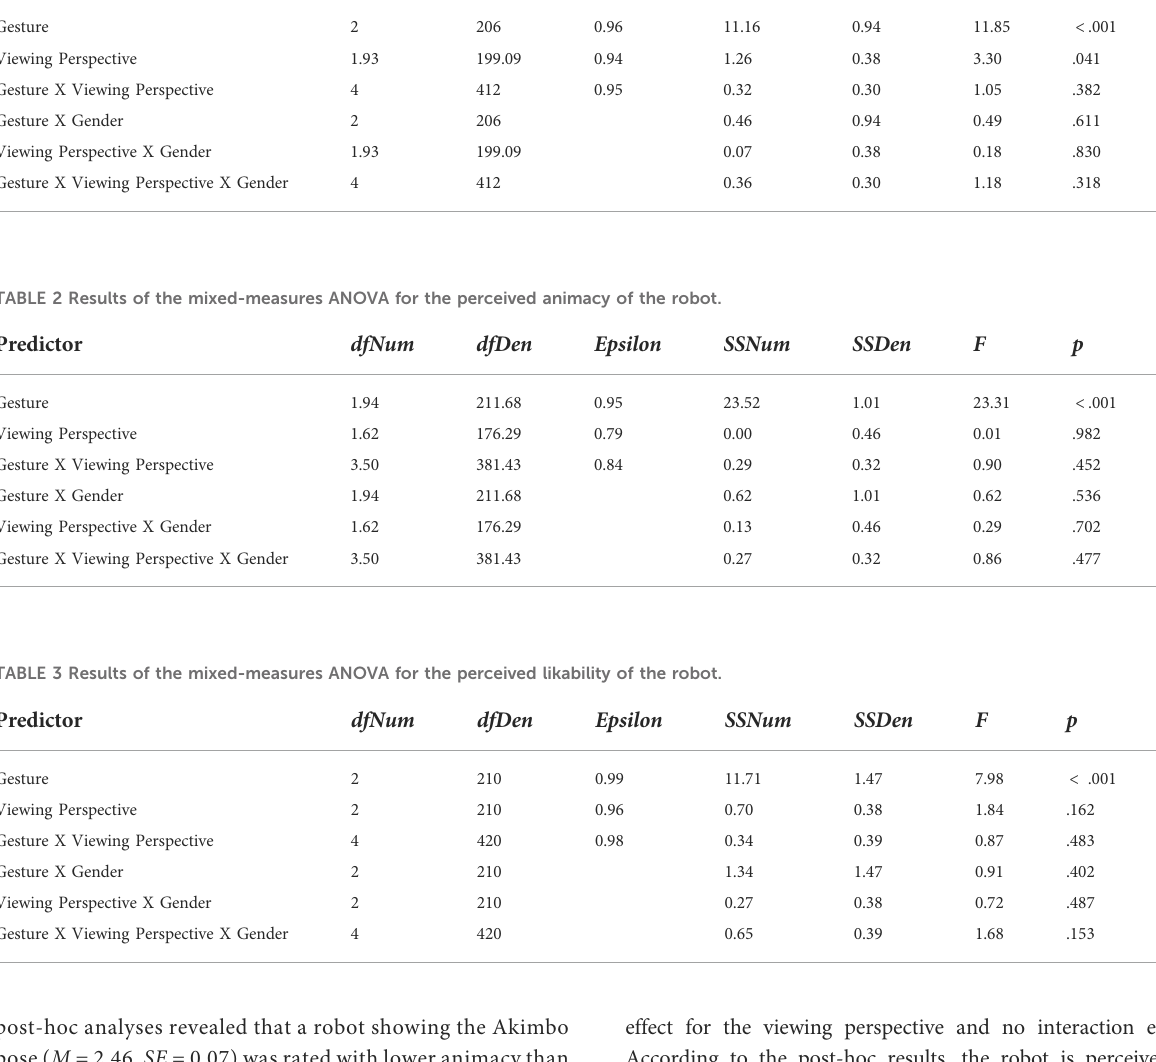
TABLE 1 Results of the mixed-measures ANOVA for the perceived anthropomorphism of the robot. Predictor dfNum dfDen Epsilon SSNum